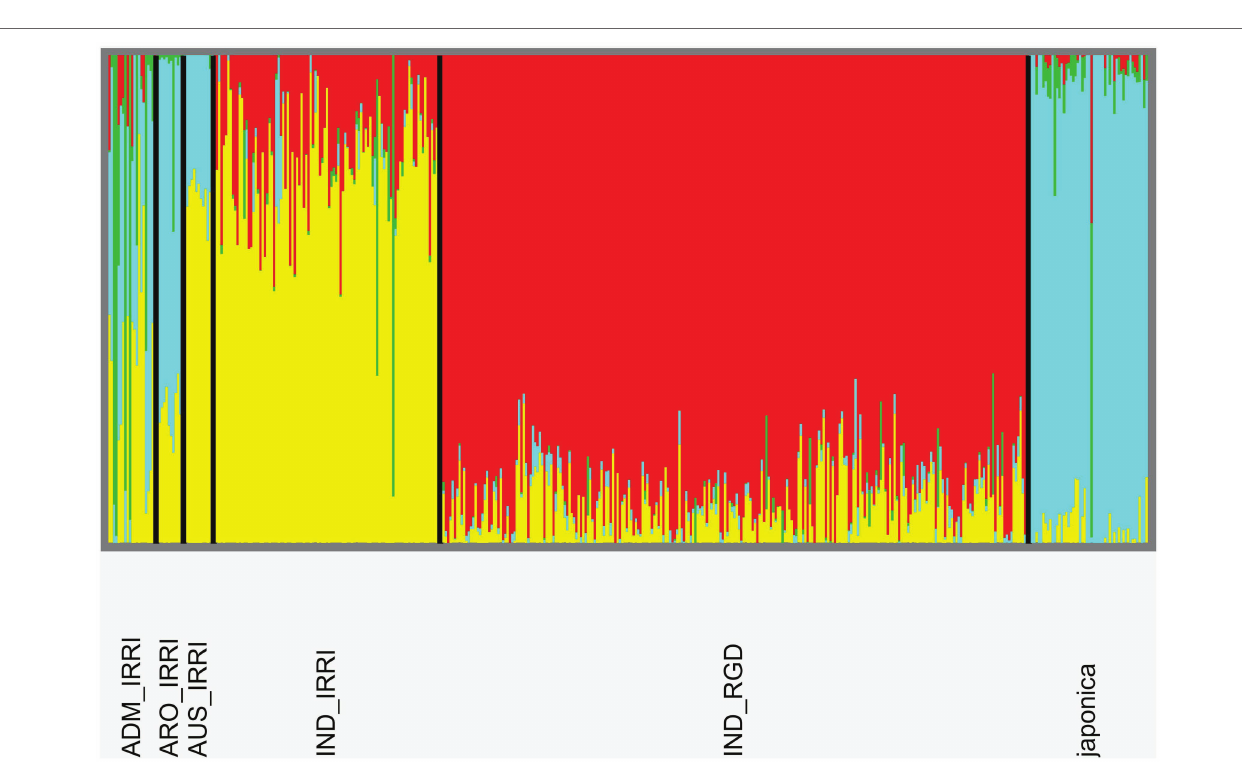
FIGURE 8 | Population genomic structure plot following analyses in s NMF software indicating relationships patterns at the four-deme level. There is clear delineation according to accession variety types although further variation appears according to library origin of indica